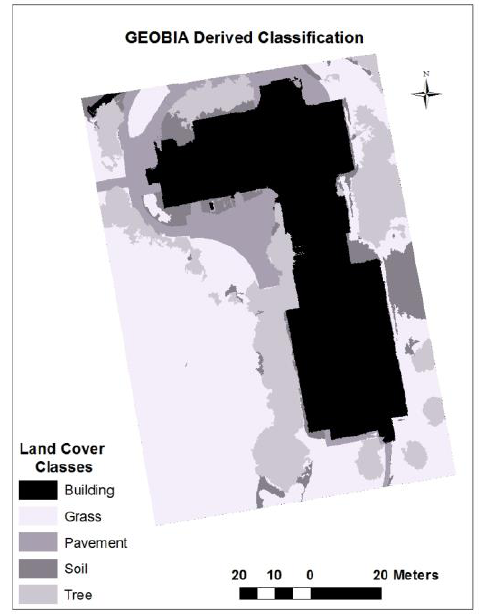
Figure 5. GEOBIA Based Land